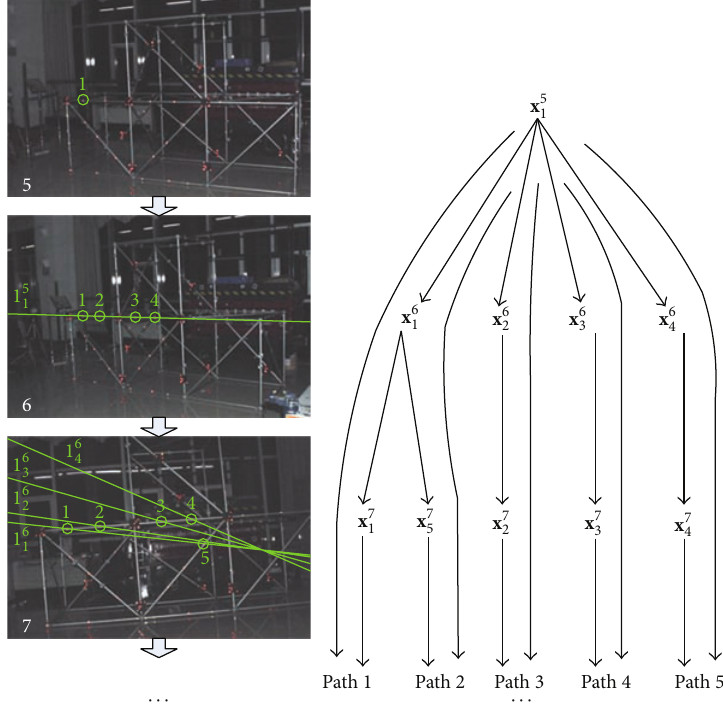
Figure 9: Finding possible matching